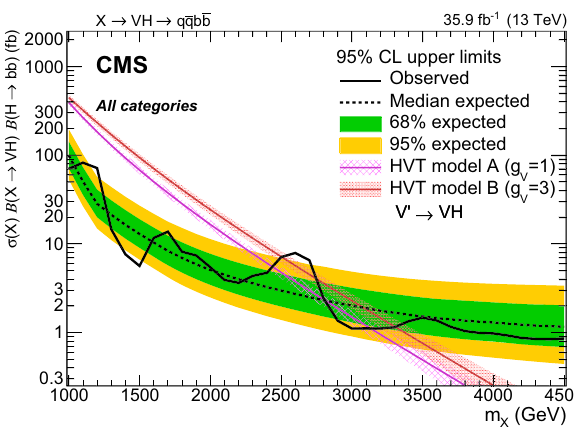
Fig. 6 Observed and expected 95% CL upper limits with the ± 1 and ± 2 standard deviation uncertainty bands on the product σ( X ) B ( X → VH ) B ( H → bb ) in the combined heavy vector triplet hypothesis, for the combination of the eight categories. The purple and red solid curves correspond to the cross sections predicted by the HVT model A and model B,